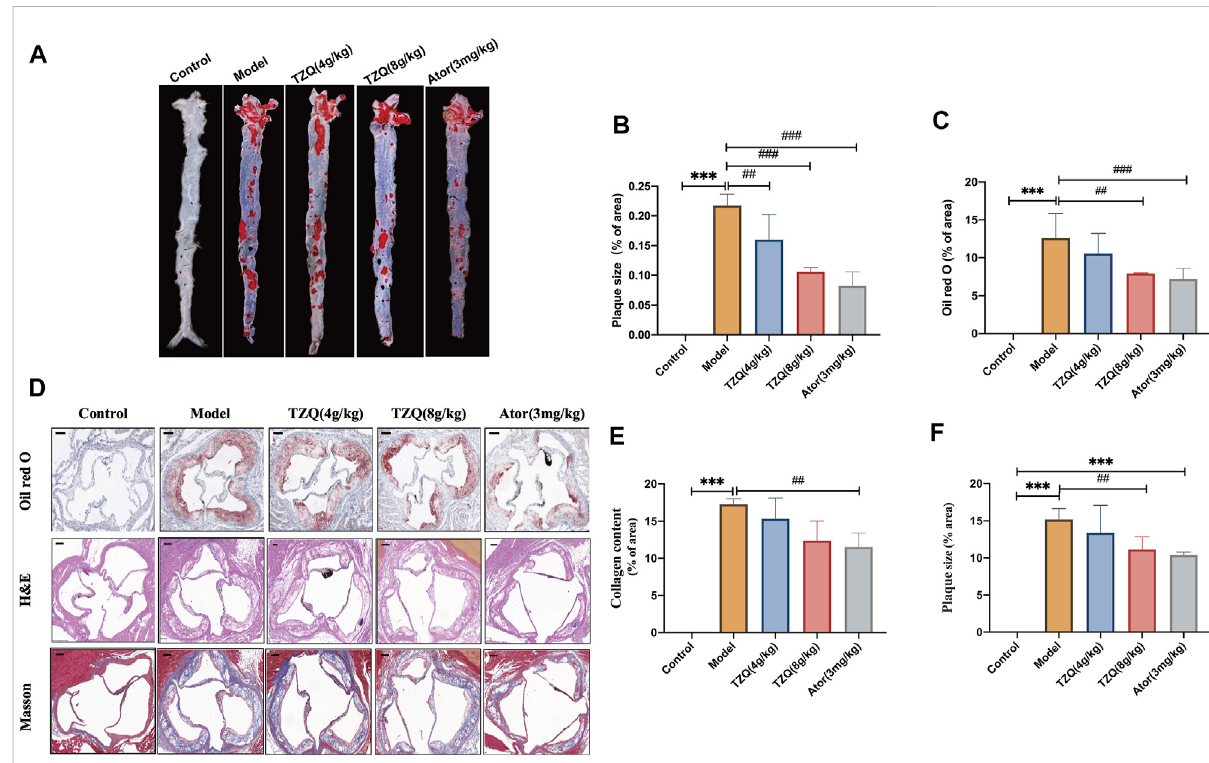
FIGURE 3 Effect of TZQ on aortic plaques. (A) :Gross OilRed O staining oftheaorta. (B) :Gross aortic plaque area. (C) :Aortic rootplaque area. (D) :OilRed Ostaining. (E) :Massonstaining(×200), (F) :Hematoxylinstaining(×200).Scalebar=50 μ m, n =4mice foreachgroup,** p < 0.05, *** p < 0.01versus Control, ## p < 0.05, ### p < 0.01 versus